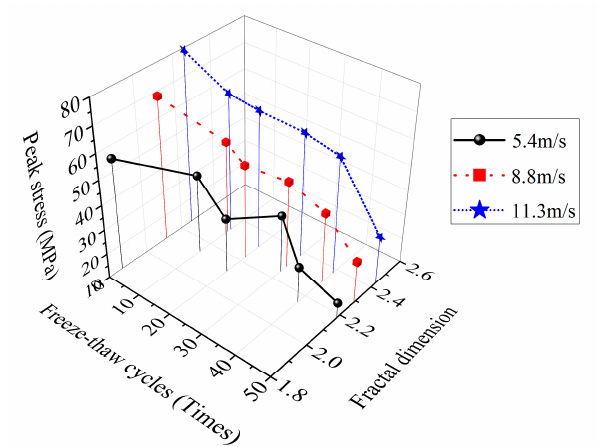
Figure 12. Relationship curves between the fractal dimension and the dynamic peak stress of concrete.